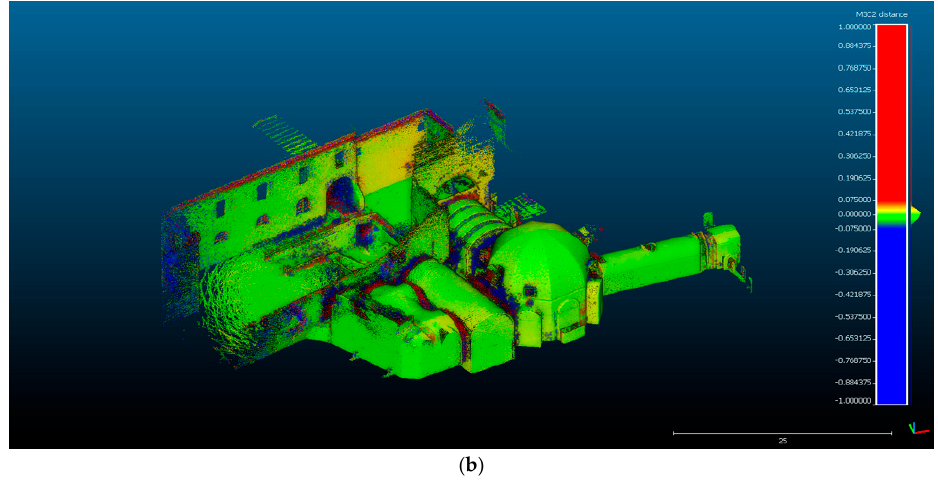
Figure 15. Signed distances of the GeoSlam Zeb-Revo dataset compared to the ground truth: ( a ) path 1; ( b ) path 2.